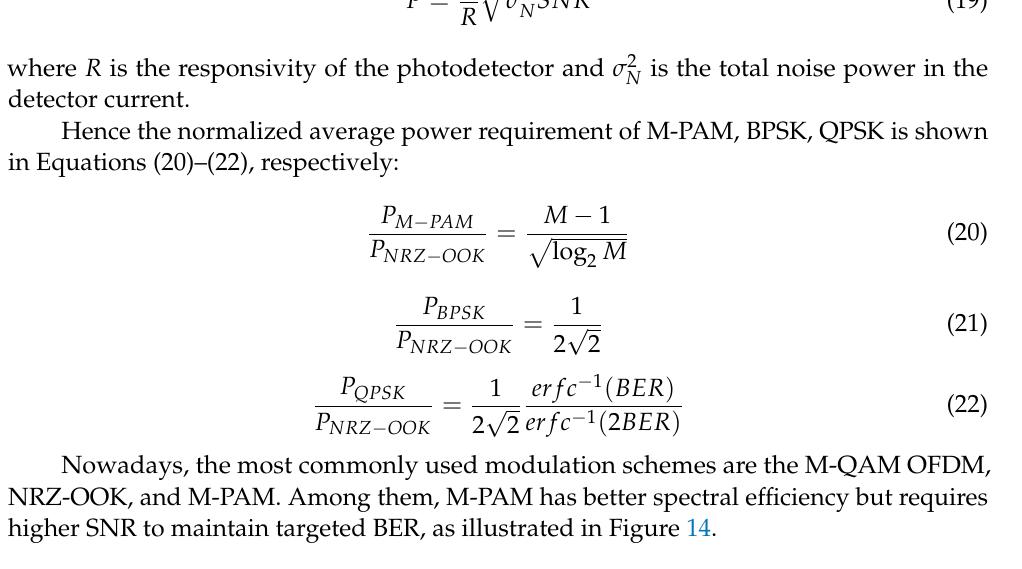
Figure 13. Chromaticity diagram. © 2015 IEEE. Reprinted, with permission from [114] . Table 4. CSK in code and chromaticity coordinates. © 2015 IEEE. Reprinted, with permission, from [114] .